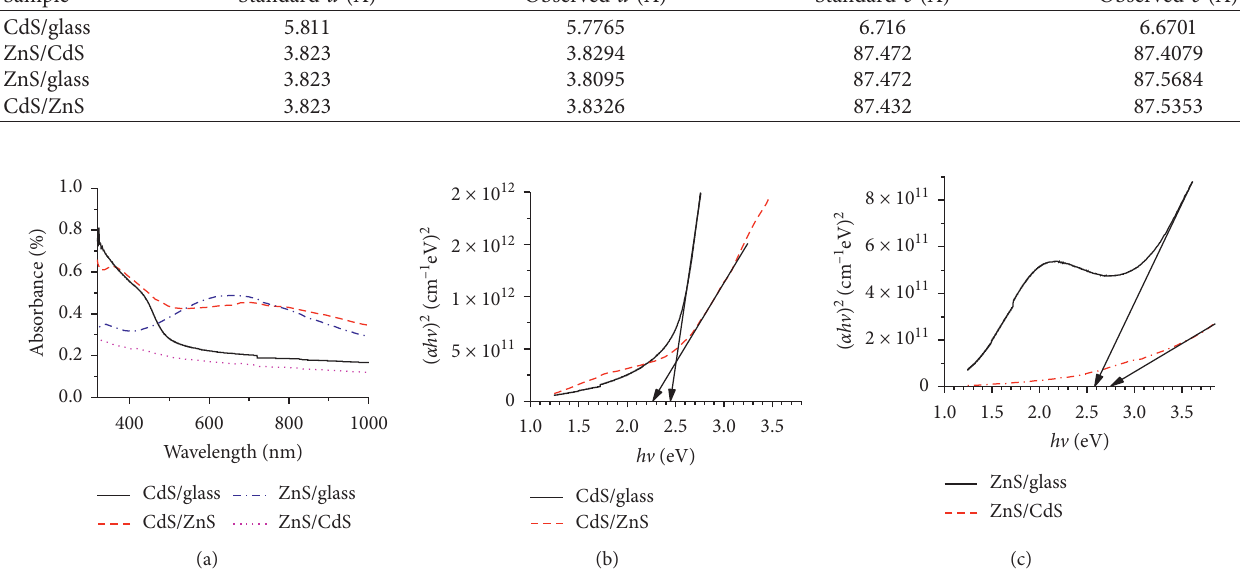
CdS/ZnS The letters “C” and “H” refer the cubic and hexagonal structures, respectively. Table 2: The standard and calculated lattice parameters of CdS/glass, CdS/ZnS, ZnS/glass, and ZnS/CdS thin films (JCPDS # used 00-010- 0454 for cubic CdS and 01-089-2174 for hexagonal ZnS). Sample